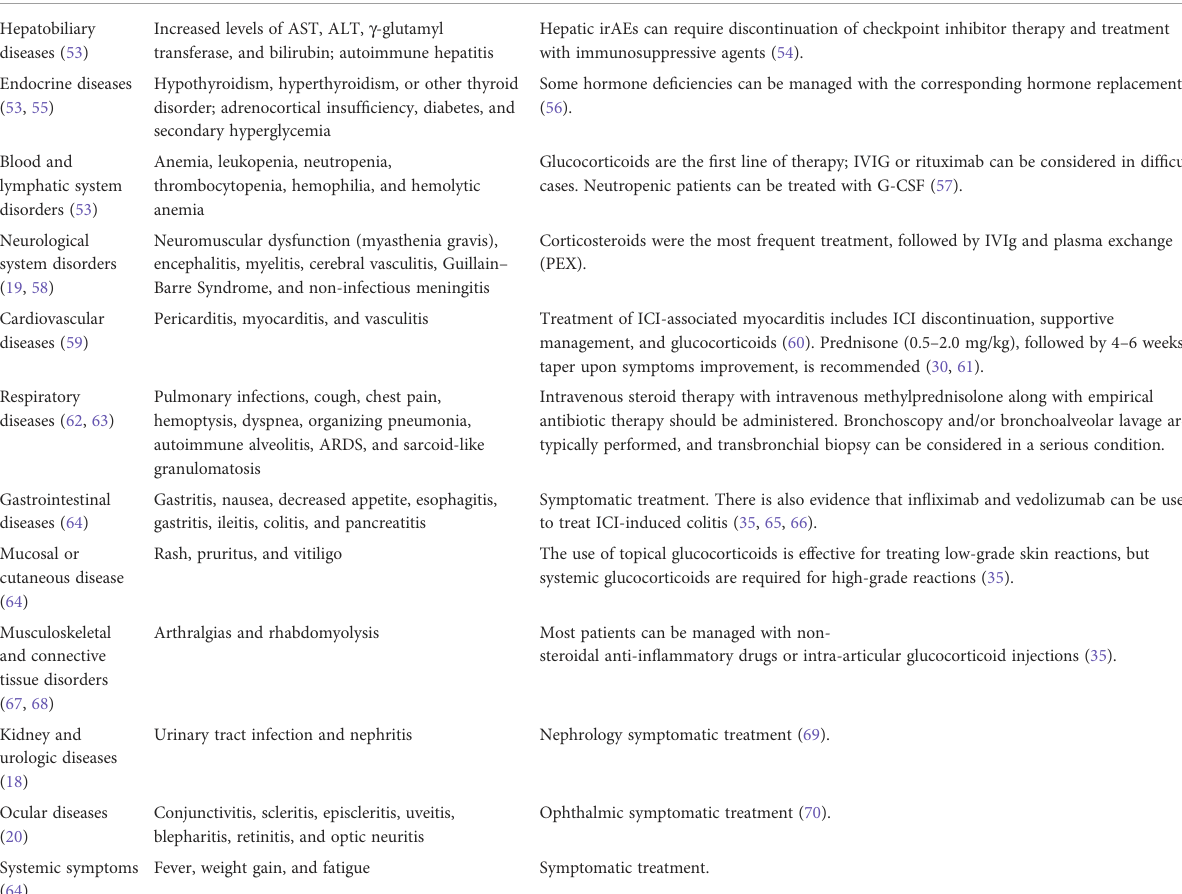
TABLE 1 ICI-induced adverse effects, clinical manifestations, and